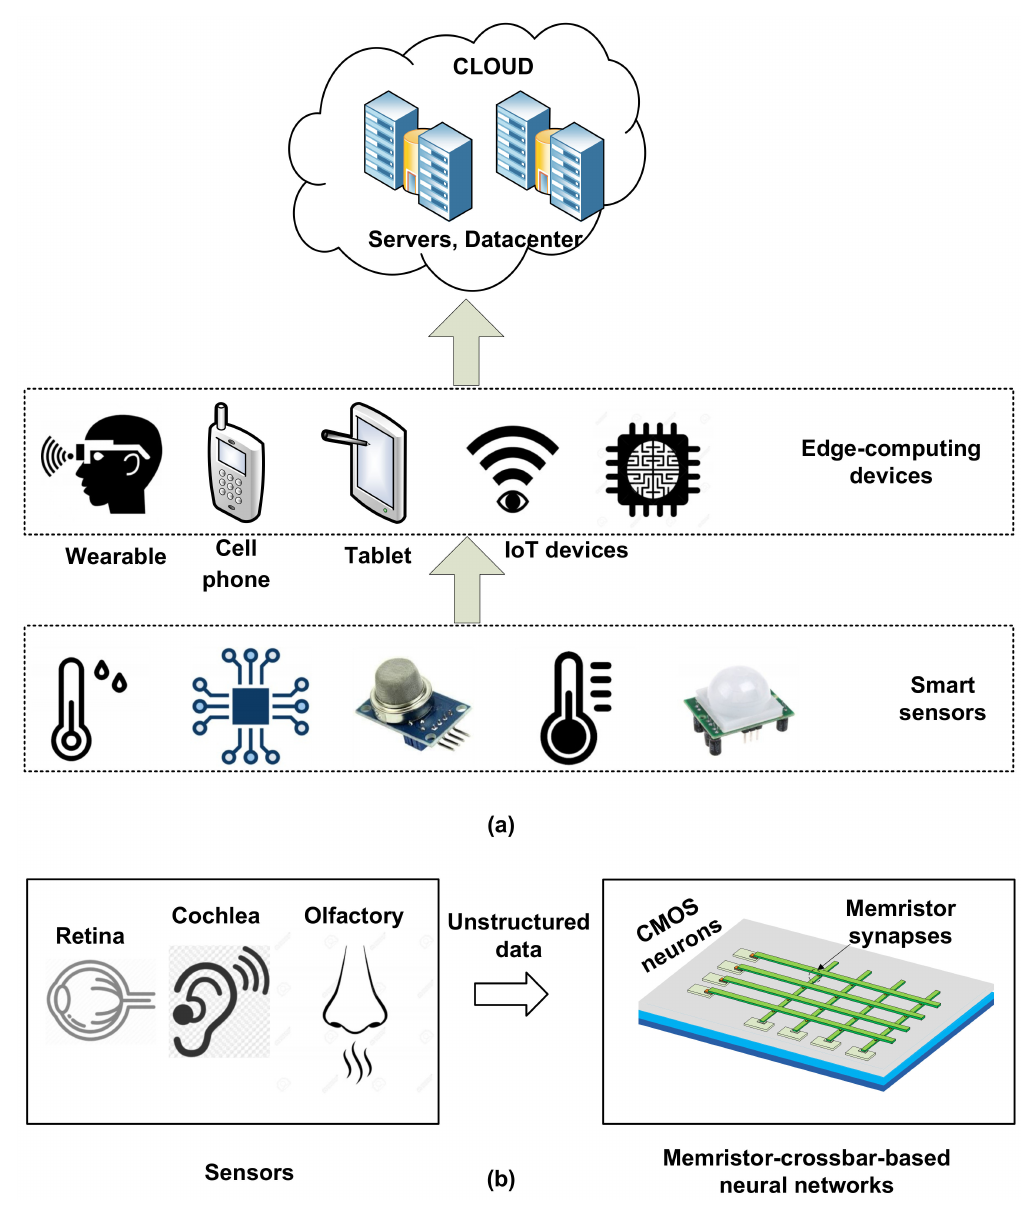
Figure 1. ( a ) The conceptual diagram of cloud, edge-computing devices, and sensors. ( b ) The block diagram of an edge-computing device composed of memristor-crossbar-based neural networks for processing the unstructured